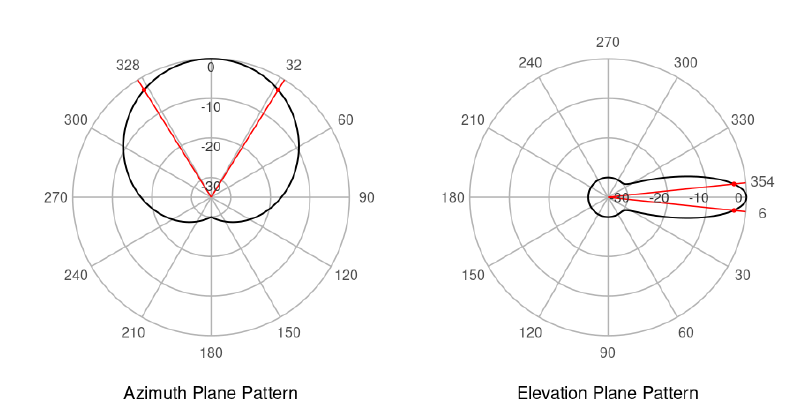
Figure 2: Radiation patterns for the azimuth and elevation planes.